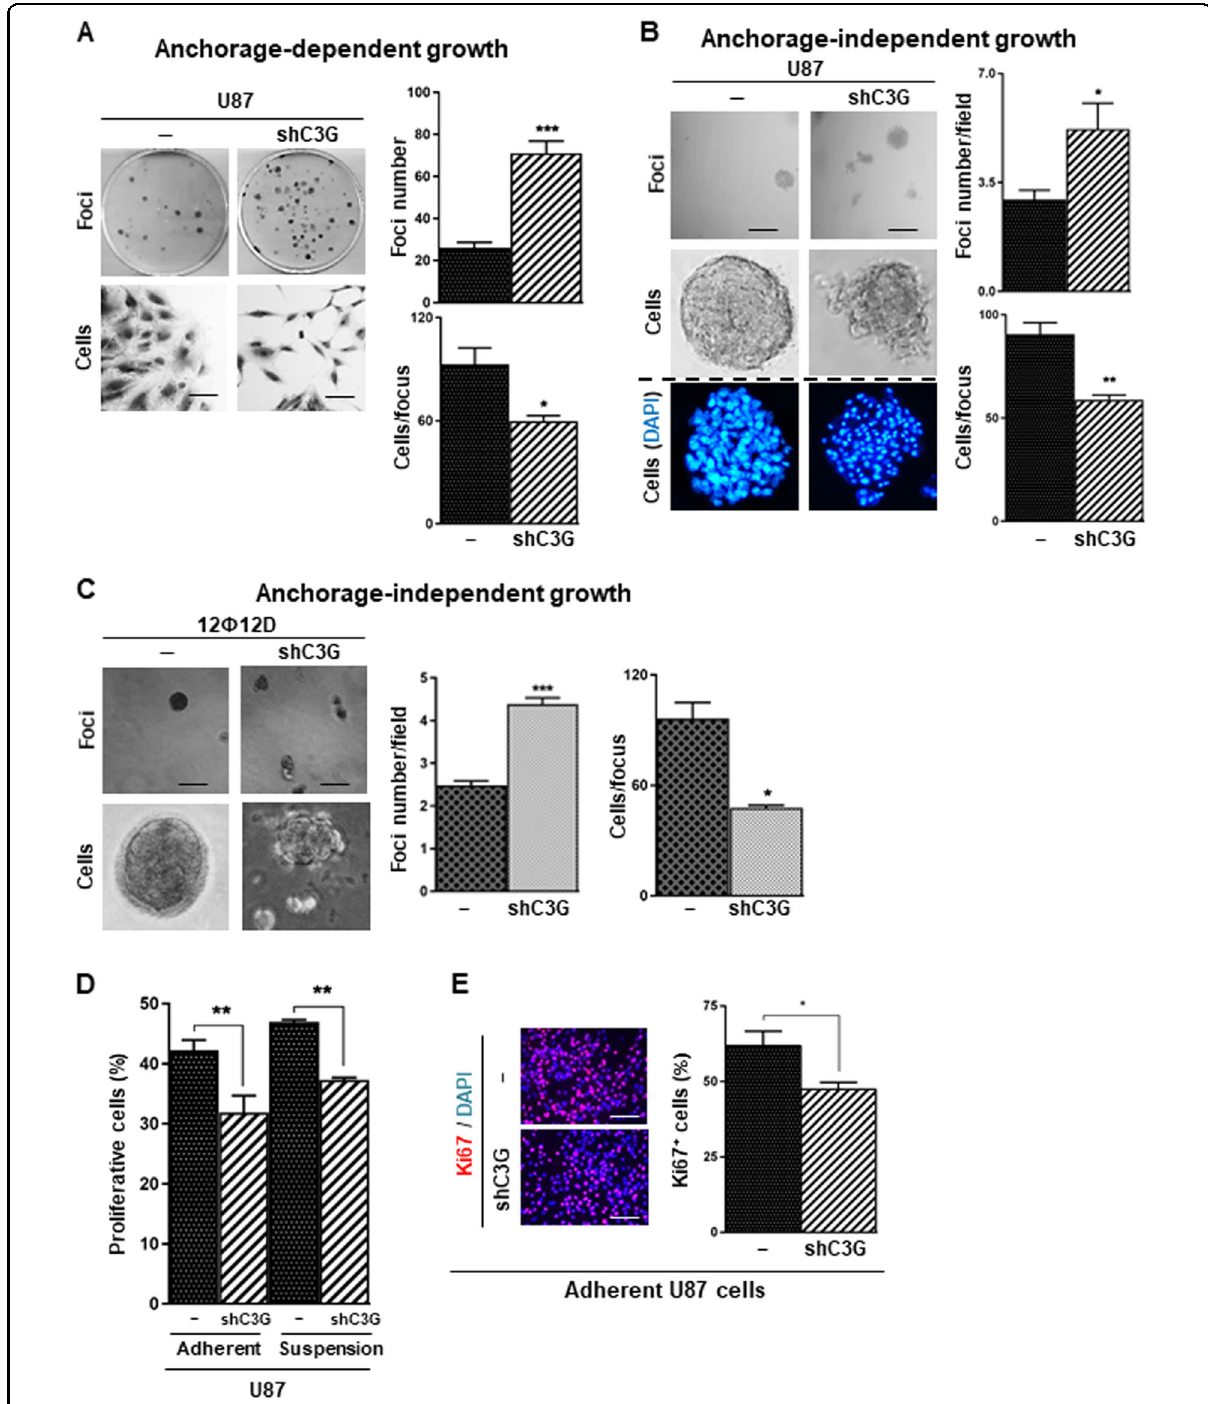
Fig. 3 (See legend on next